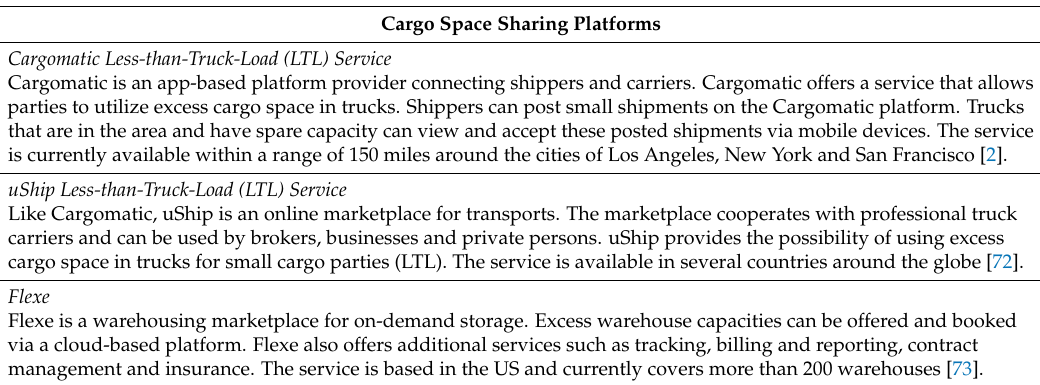
Table 6. Practical examples of cargo space sharing platforms.